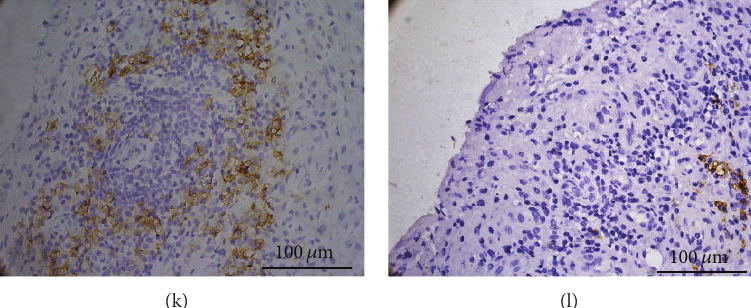
Figure 2: Histopathological features of synovium of 2 RA patients (400x). Images of the left column were from one RA patient with higher synovial IgG4-positive plasma cells and the right column from another RA patient with lower synovial IgG4-positive plasma cells. (a, b) H&E staining. (c, d) IgG4 immunohistochemistry staining. (e, f) Masson’s trichrome staining. (g, h) CD3 immunohistochemistry staining. (i, j) CD20 immunohistochemistry staining. (k, l) CD38 immunohistochemistry